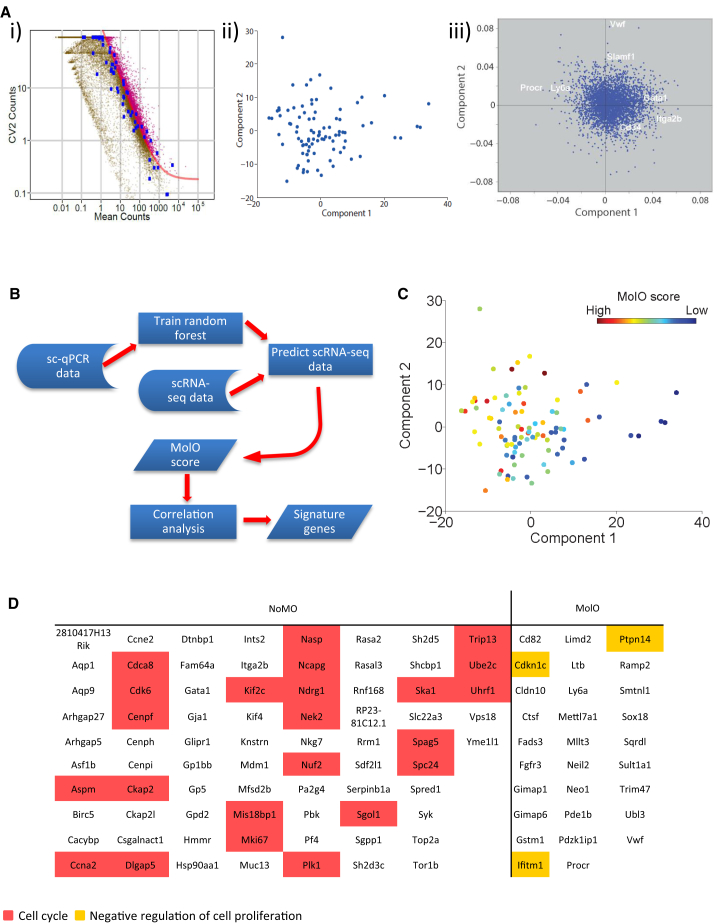
Genome-wide Expression Pattern of 92 Single HSCs Reveals a Gene Signature for the MolO Population(A) RNA-seq analysis. (i) Identification of variable genes across all 92 cells. The genes highlighted in magenta have a coefficient of variation exceeding technical noise. The blue dots represent the distribution of the internal control ERCC spike-ins. (ii) PCA plot for the 92 cells analyzed by RNA-seq, showing the first and second components for all genes which were identified to be variably expressed. (iii) Principal component loading plot of scRNA-seq, indicating which genes also assayed by Fluidigm analysis and/or flow cytometry contribute to the separation of the cells along each component.(B) Schematic showing the principle of the classifier to determine the MolO HSCs from the scRNA-seq dataset.(C) PCA plot showing MolO score.(D) Table of signature genes differentially expressed in either NoMO or MolO cells following correction for multiple testing at a false discovery rate (FDR) of 0.1. Coloring relates to the GO term associated with the gene: red, cell cycle; yellow, negative regulation of cell proliferation.See also Figure S3 and Tables S2 and S3.